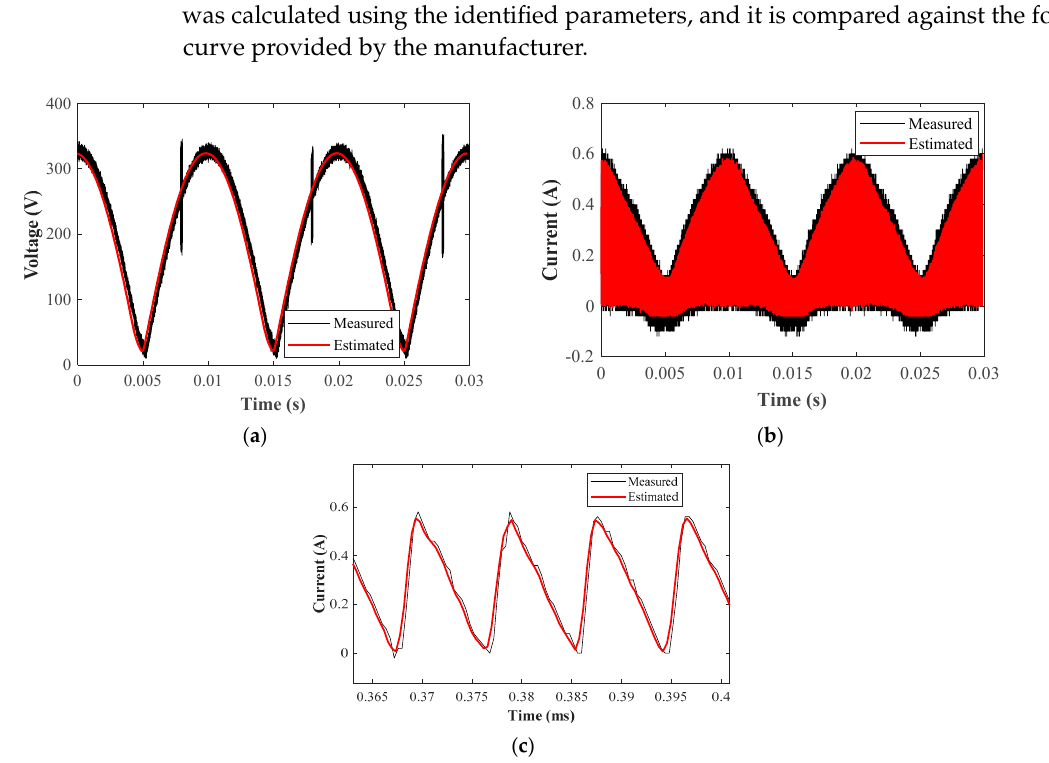
Figure 13. Measured and estimated waveforms of the rectifier. ( a ) Output voltage; ( b ) output current; ( c ) output current switching